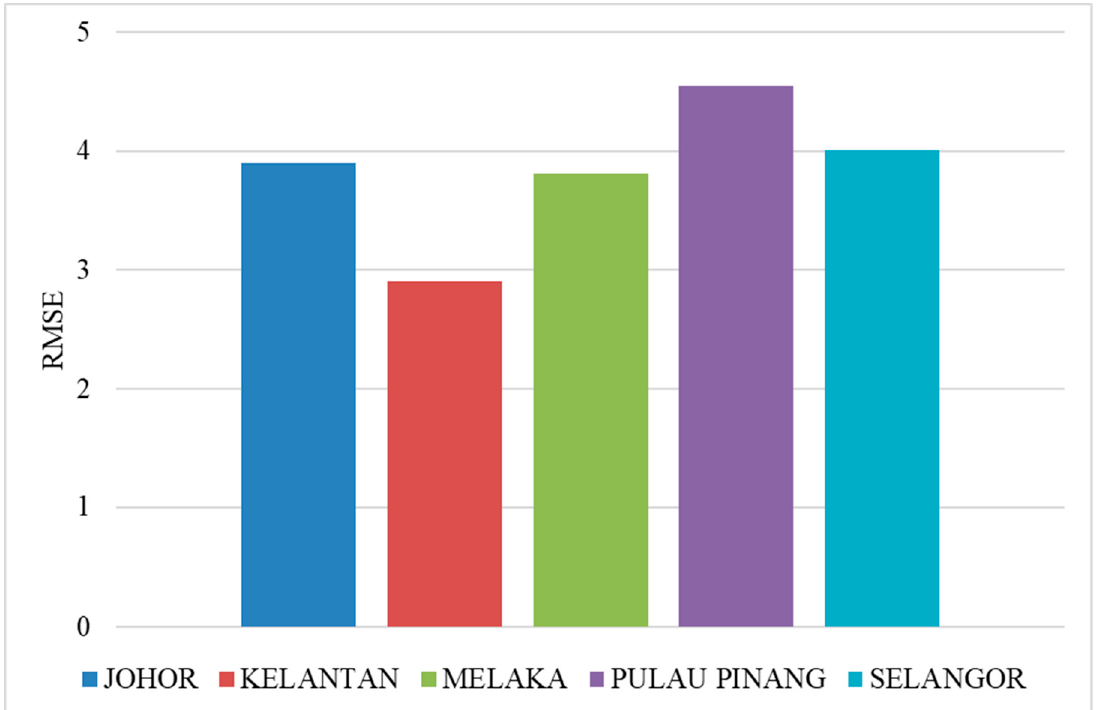
Figure 9. Average performance of SSA-LSTM model for dengue fever prediction in five Malaysian states, measured by RMSE.